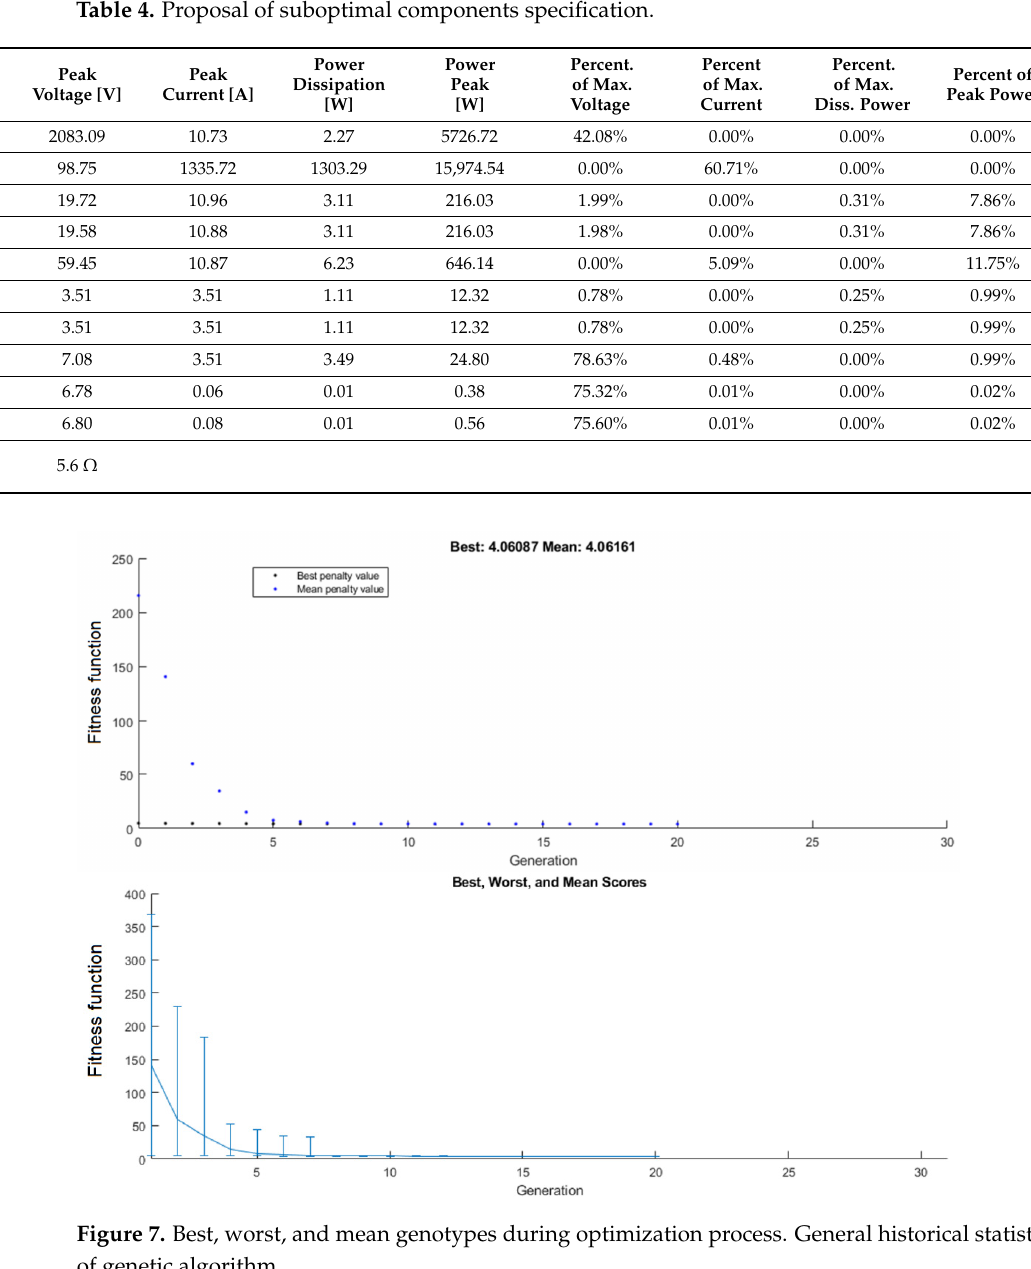
Figure 8. Average distance between individuals for each generation.